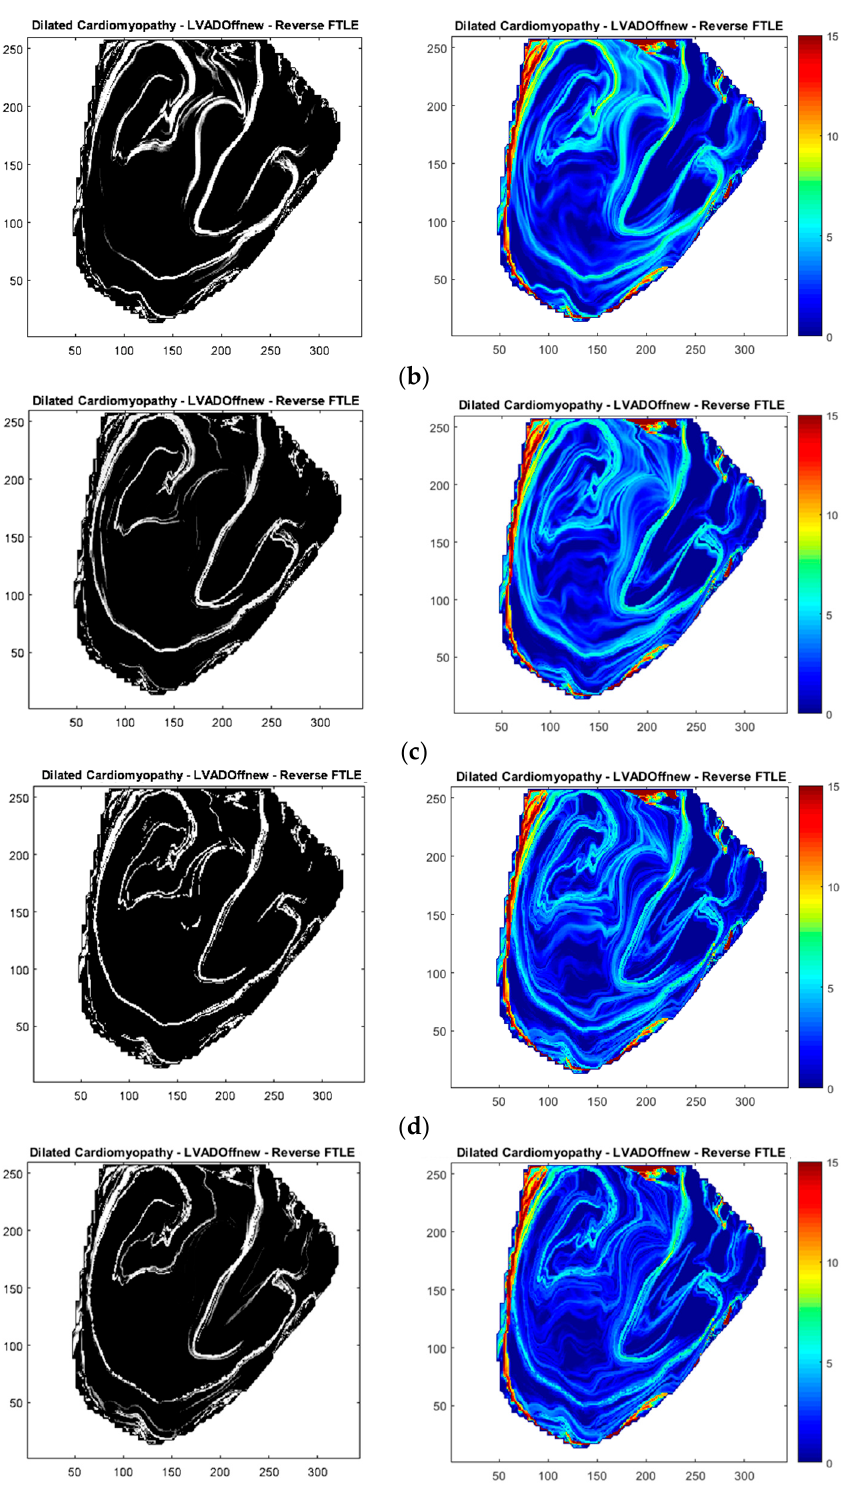
Figure 2. Reverse time integration of finite time Lyapunov exponent (FTLE) is performed to identify Lagrangian Coherent Structure (LCS) ridges. ( a ) Integration time = 0.2 s; ( b ) Integration time = 0.5 s; ( c ) Integration time = 0.7 s; ( d ) Integration time = 0.9 s; ( e ) Integration time = 1.2 s.